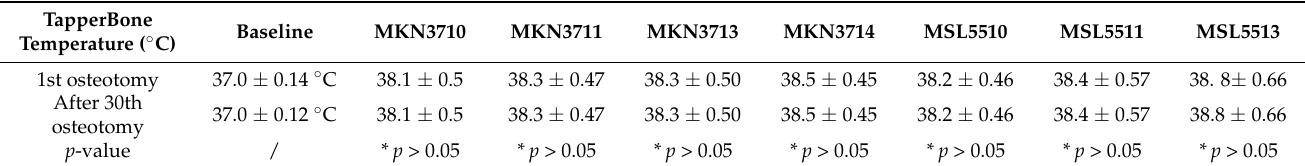
Table 2. Summary of the statistical analysis of the bone tappers temperature [Mann–Whitney Test; * p < 0.05].